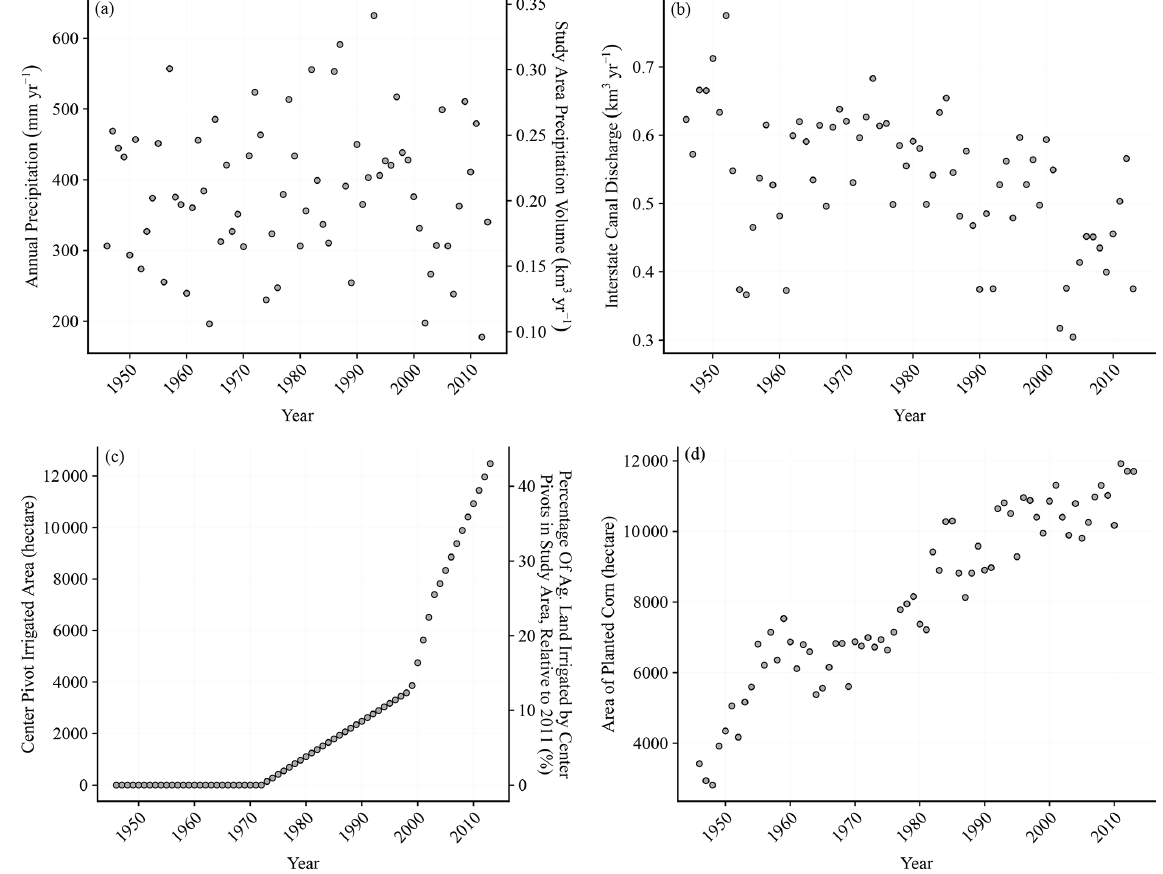
Figure 3. Time series plots of all four dynamic predictors. Figures represent the (a) annual precipitation, (b) Interstate canal discharge, (c) center pivot irrigated area, and (d) area of planted corn from 1946 to